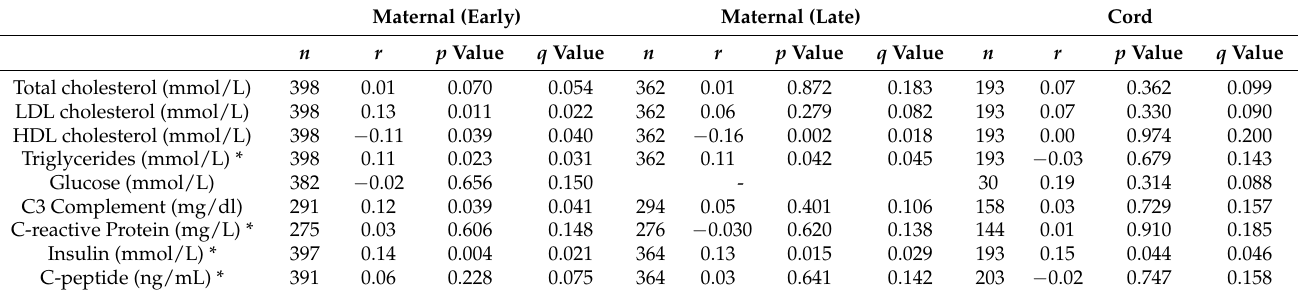
Table 3. Correlations between E-DII TM in early pregnancy and maternal and cord cardiometabolic markers. Maternal (Early) Maternal (Late) Cord n r p Value q Value